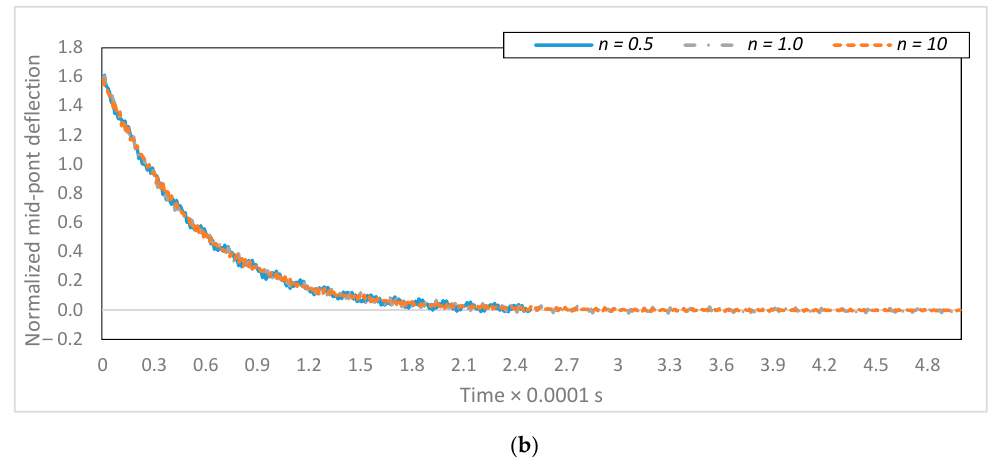
Figure 9. Deflection of the clamped-clamped micro-switch for various volume fractions: ( a ) the uncontrolled system and ( b ) the controlled system.